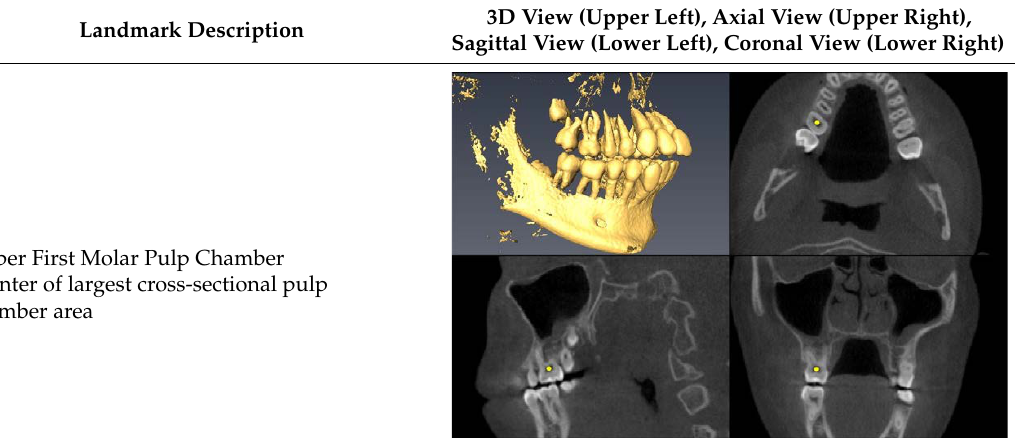
Table 3. Craniofacial landmarks